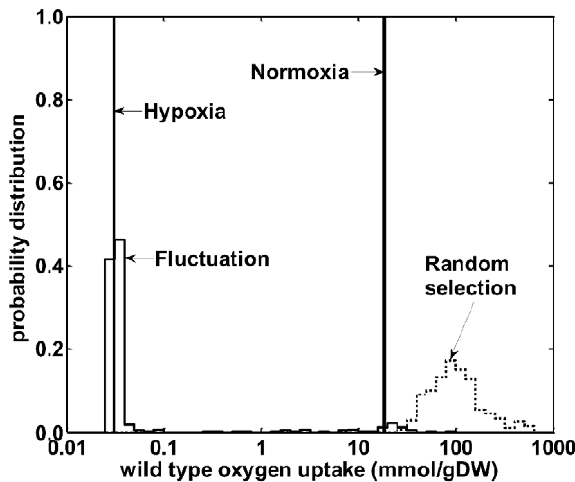
Figure 3. Variations of oxygen uptake of wild type Mycobacte- rium tuberculosis H37Rv are compatible with experimental fluctuations. The solid vertical bars indicate the wild type normoxic- and hypoxic-normalized oxygen uptake rates based on our integrated metabolic network model and correspond to the same values given in Figure 2A. We calculated the distribution of uptake values by sampling each expression value from a normalized distribution based on its mean and standard deviation and calculating the resultant uptake rates. This distribution, labeled ‘‘Fluctuations’’ in the graph, captured the experimental gene expression variability and was centered on the value derived from using the mean expression values. In contrast, the distribution labeled ‘‘Random selection’’ was derived from randomizing all gene expression data and was far away from either the normoxic or hypoxic conditions. This confirmed that the gene expression data carried sufficient information to guide the metabolic network model to describe the organism’s adaptations under hypoxia. The units are mmol per gram dry weight of Mycobacterium tuberculosis .